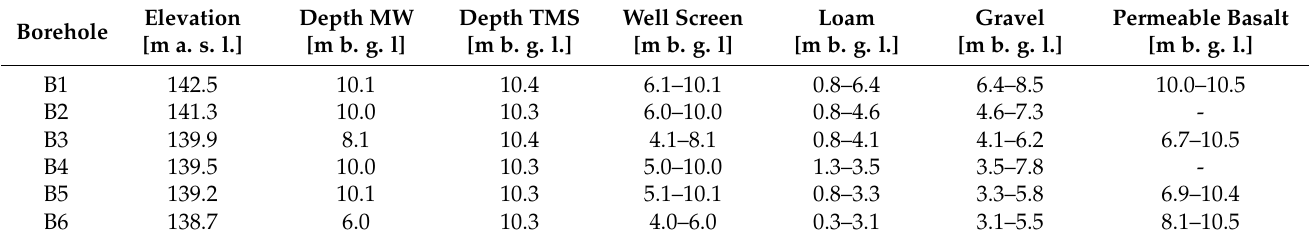
Table 2. Elevation at the location of the MWs and TMSs in metres above sea level (m a. s. l.), depth of bottom of MW and TMS, location of PVC well screen in the MWs, extent of geological units; ‘permeable basalt’ refers to areas where the decomposed basalt is presumed to be permeable, although it may not always be